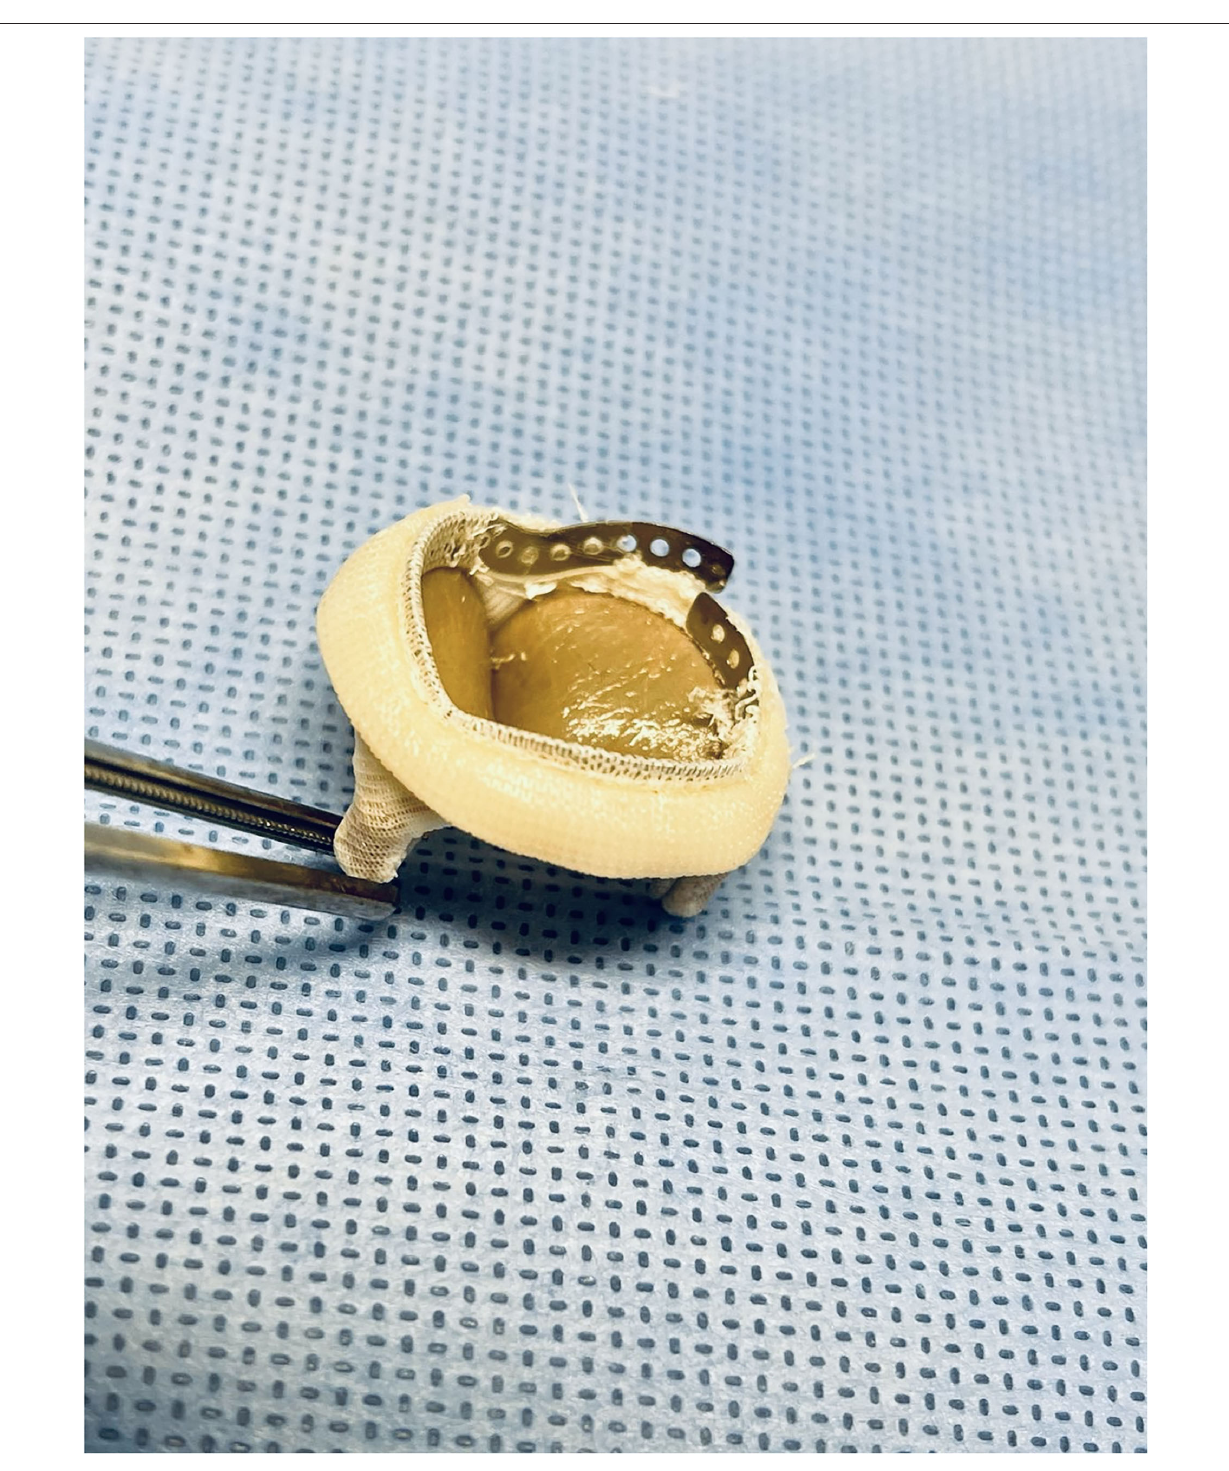
7.5 mmHg; p < 0.001) at 30 days and remained stable for up to 1-year of follow-up (11). BVF-related complications, such as stroke, annular rupture, and coronary obstruction,